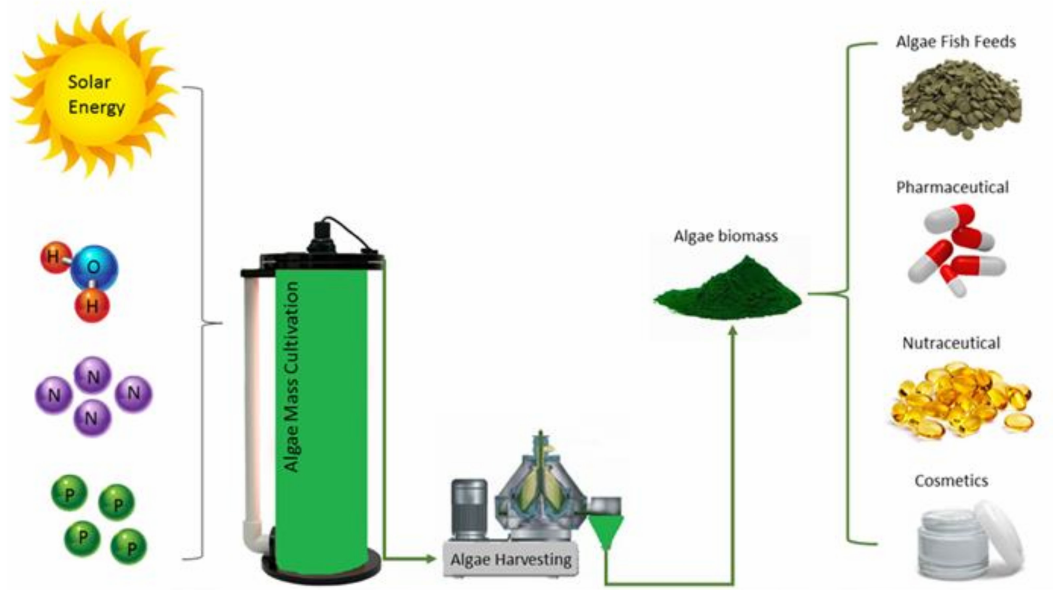
Figure 2. Microalgae cultivation with availability of essential nutrients and potential